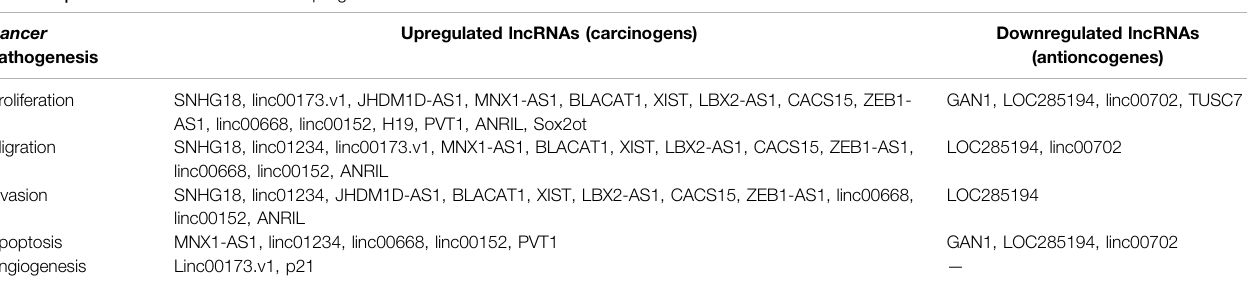
TABLE 4 | The mechanism of lncRNAs as prognostic biomarkers in